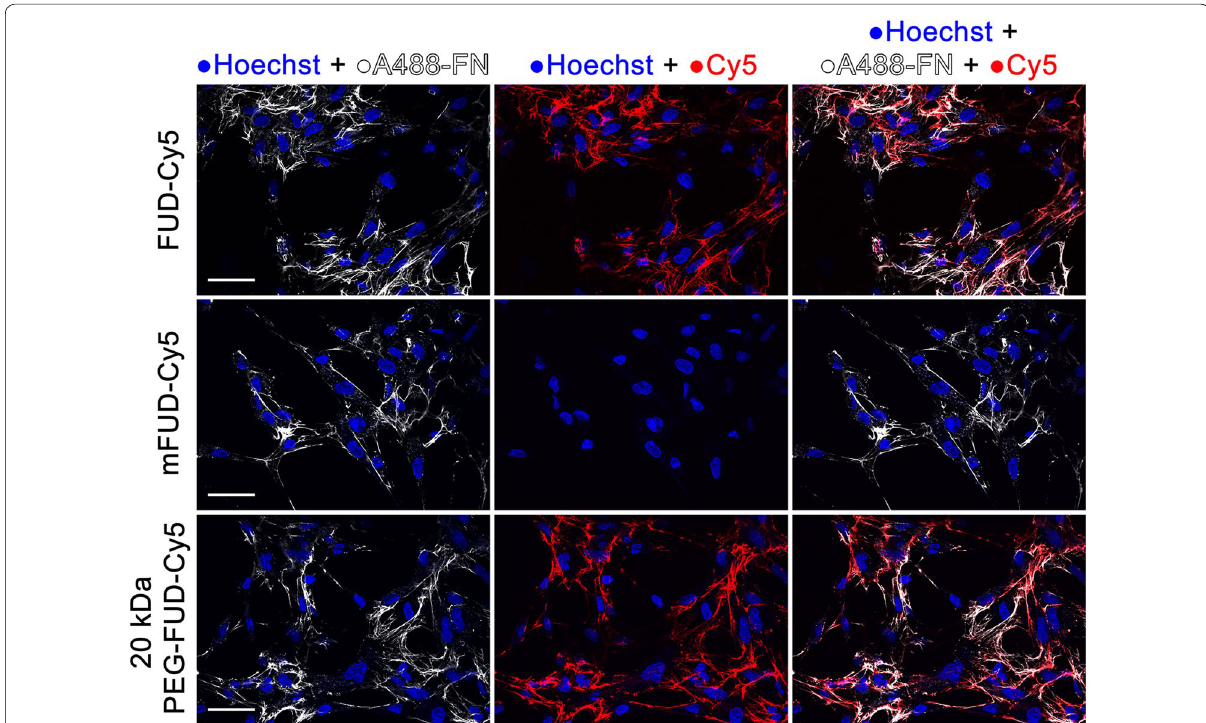
Fig. 6 Confocal fluorescence microscopy experiments showing binding of sulfo-Cy5 labeled FUD and 20 kDa PEG-FUD, and lack thereof for mFUD-Cy5, to Alexa Fluor 488 labeled human plasma fibronectin (A488-FN) surfaces assembled by AH1F human foreskin fibroblasts in a glass bottom dish. Each column indicates overlay of listed signal. Overlay of the A488-FN and the peptide-Cy5 signal (last column) reveals colocalization of fibronectin and bound drug. Scale bars 50 =